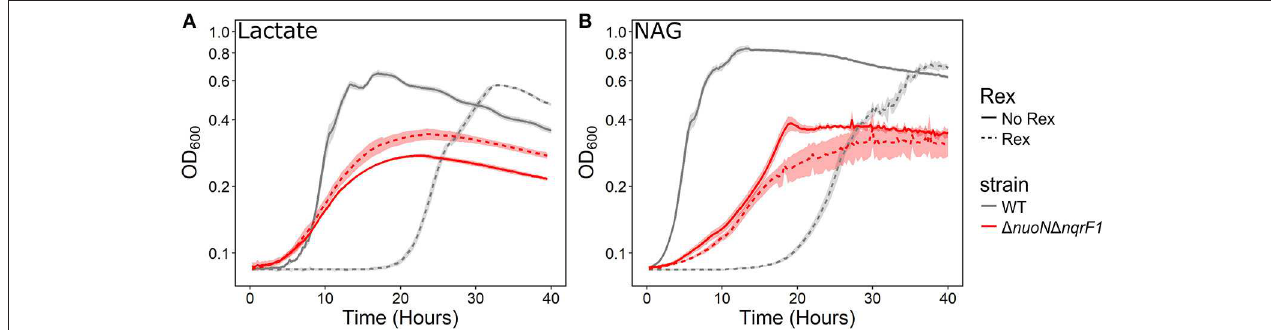
FIGURE 7 | Comparison of growth of WT (gray) and 1 nuoN 1 nqrF1 (red) strains with (solid line) and without (dashed line) the Rex redox sensor in M5 supplemented with 0.1% tryptone and (A) 20mM D,L- lactate or (B) 10mM NAG. Growth conditions were done in 1-mL culture volumes in 24-well plates at 30 ◦ C with shaking.